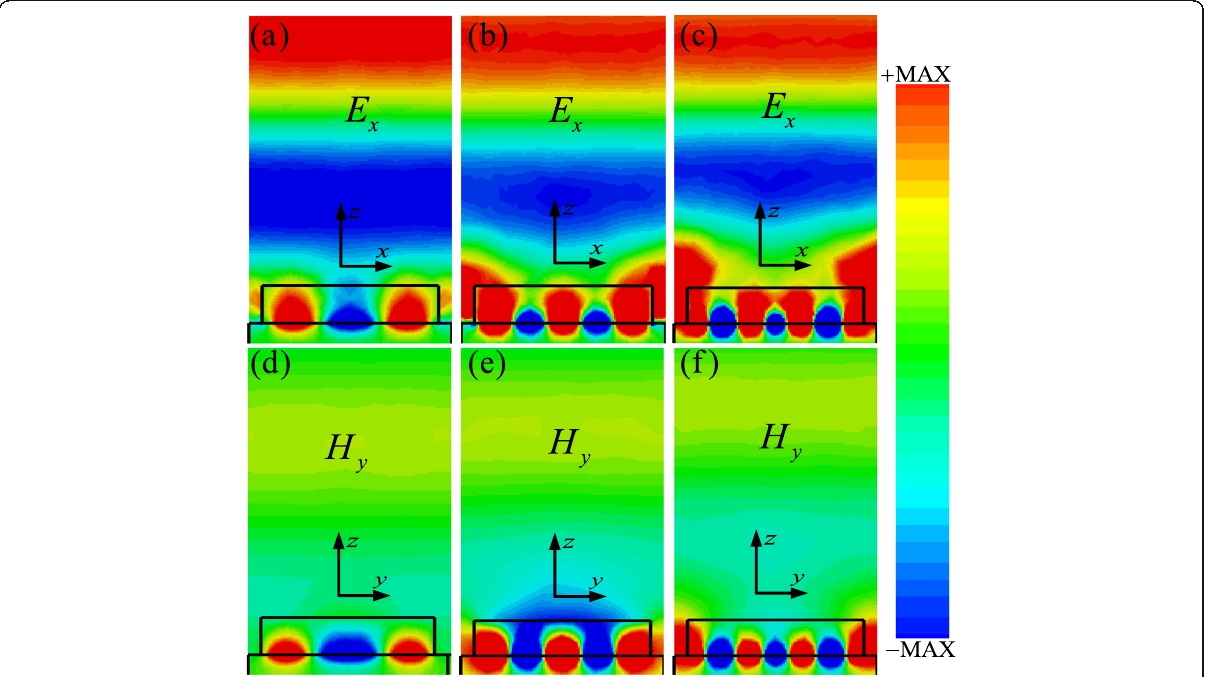
Fig. 3 Distributions of the a – c electric field ( E x in the x-z plane of y = 0 nm) and d – f magnetic field ( H y in the y-z plane of x = 0 nm) in the unit- cell nanostructure of the PLA at different resonance frequencies: ( a , d ) f 1 = 402.5 THz, ( b , e ) f 2 = 429.5 THz, and ( c , f ) f 3 = 471.5